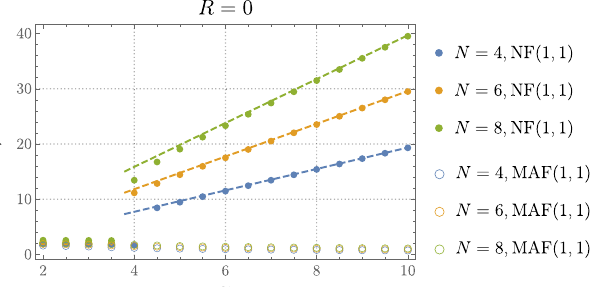
FIG. 2. Expectation value of the radius in the zero fermion sector of the mini-BMN model, for different N and ν . The dashed lines are the semiclassical values (4.4). Solid dots are initialized near the fuzzy sphere configuration, and the open markers are initialized near zero. We have used normalizing and autoregres- sive flows, respectively, as these produce more accurate varia- tional wave functions in the two different regimes.